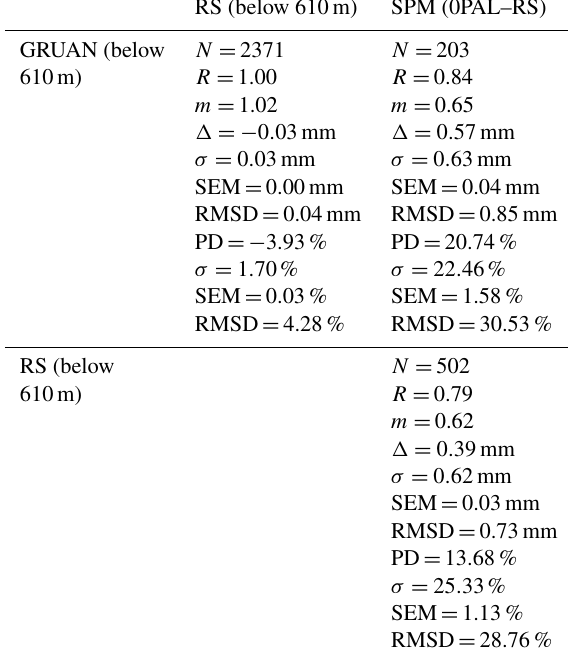
Table 6. Results of intercomparison of PWV measurements of par- tial columns between 0PAL and the Ridge Lab, including number of coincidences ( N ), correlation coefficient ( R ), slope of the corre- lation best fit line ( m ), mean difference ( (cid:49)) , standard deviation of difference ( σ) , standard error of the mean (SEM), and root-mean- square difference (RMSD) in mm ( X − Y ) and % (2 × (X − Y)/(X + Y) × 100%). Instruments along the x axis (top) are X while instru- ments along the y axis (side) are Y in Eqs. (1) and (2).